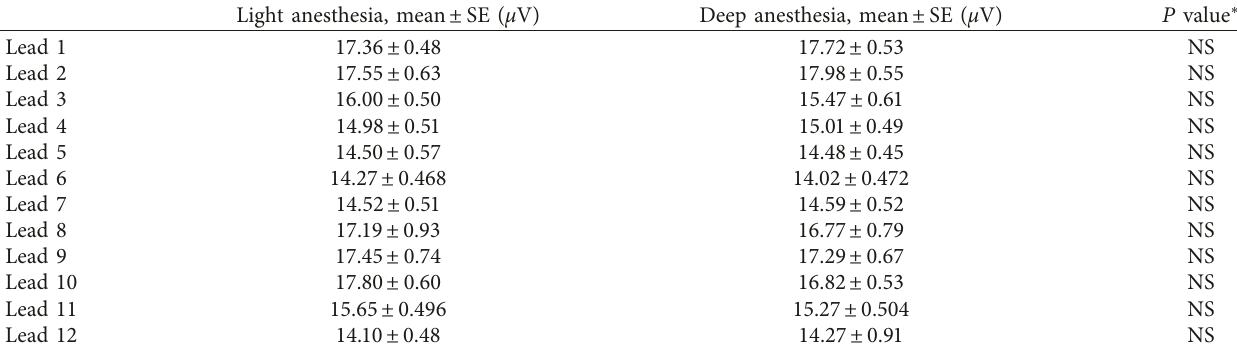
Table 1: The e-ECAP measurements in different leads within light and deep